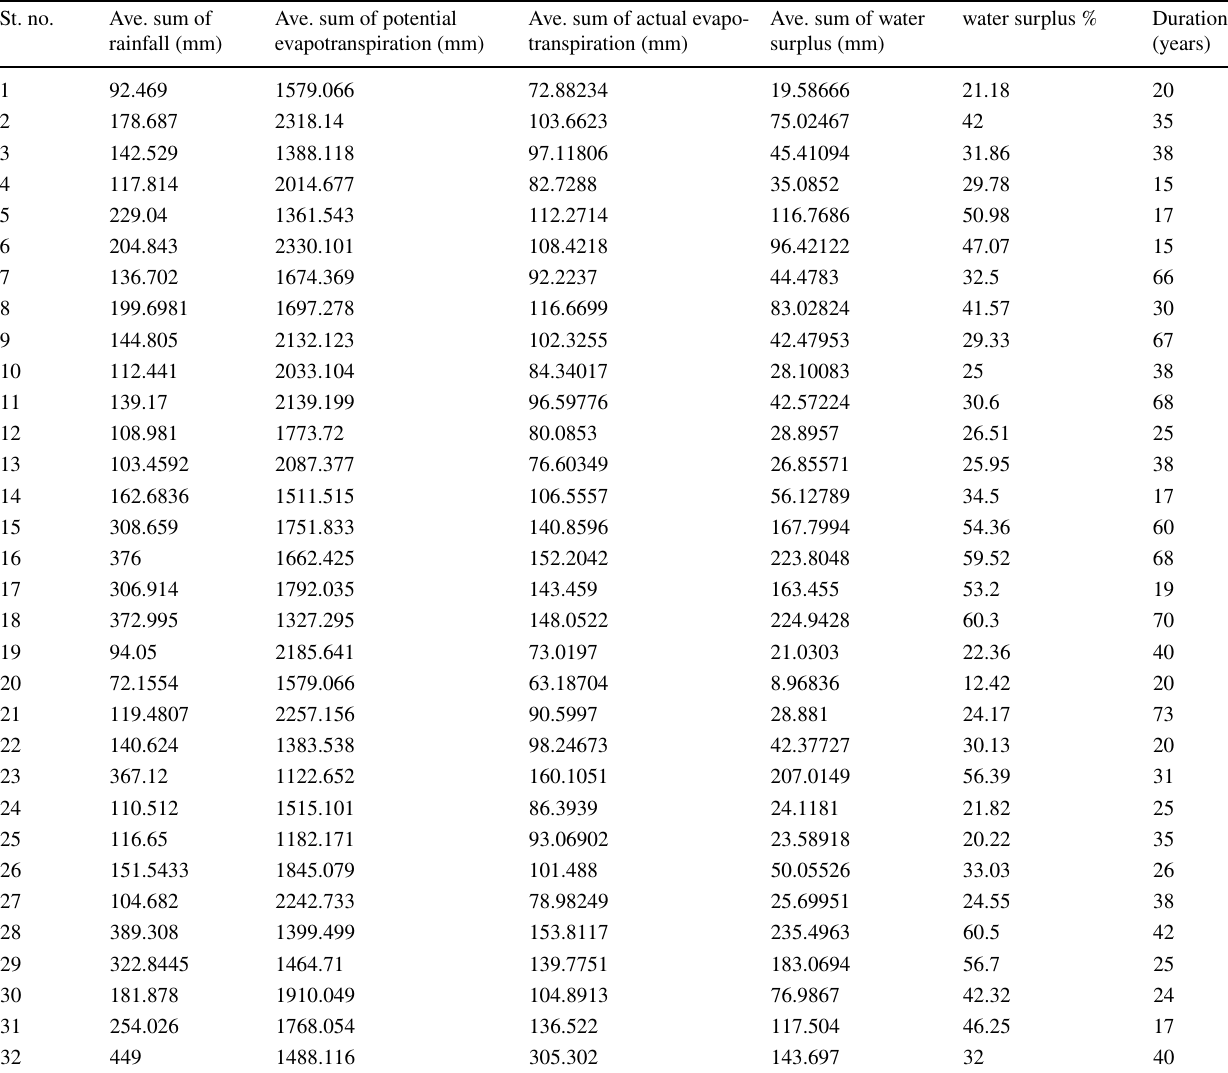
Table 2 Mean rainfall, (PEc), (AE), and (WS) in meteorological station in Iraq St.